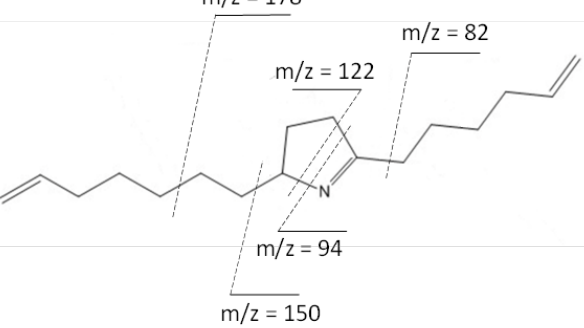
Figure A4. Suggested occurences of cleaving of the C 3 molecule with the corresponding m / z of the generated ion.